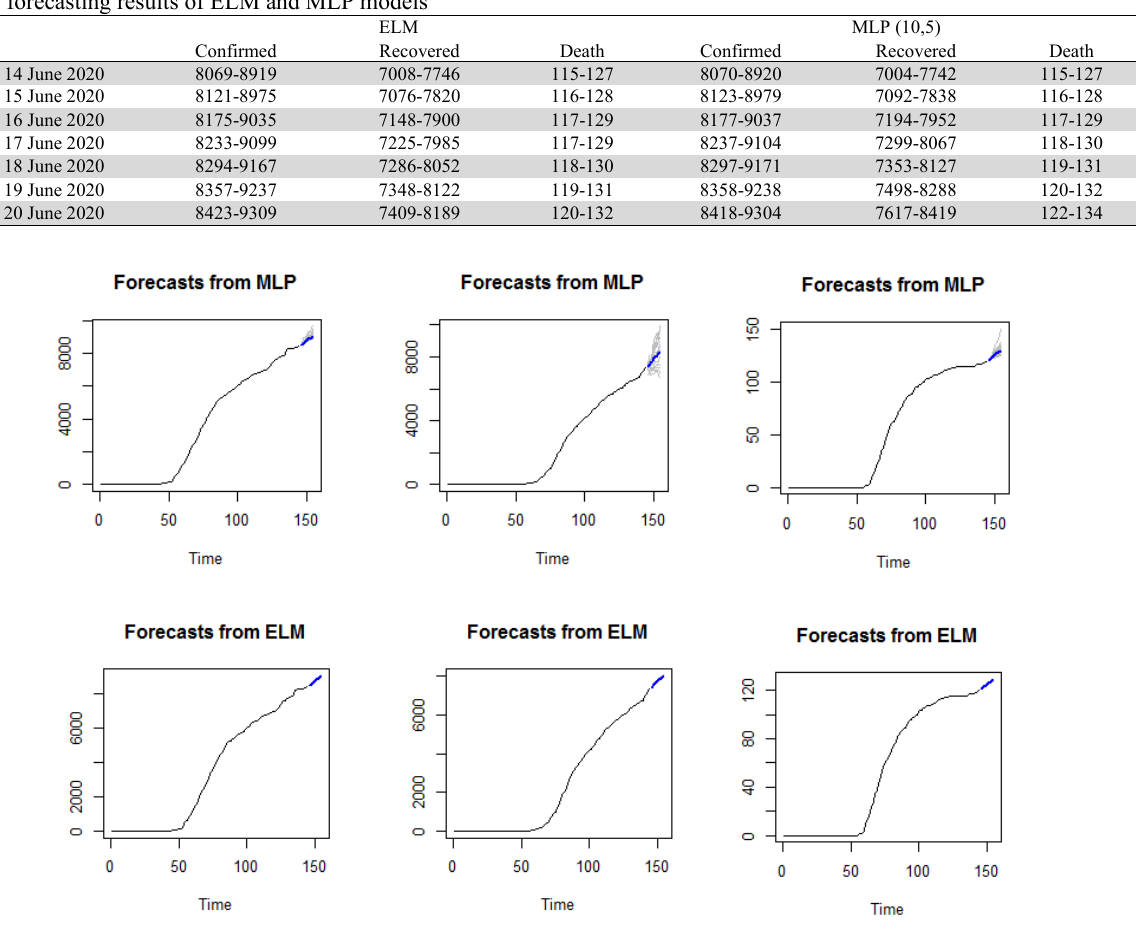
Fig. 2. Results of forecasting using ELM and MLP